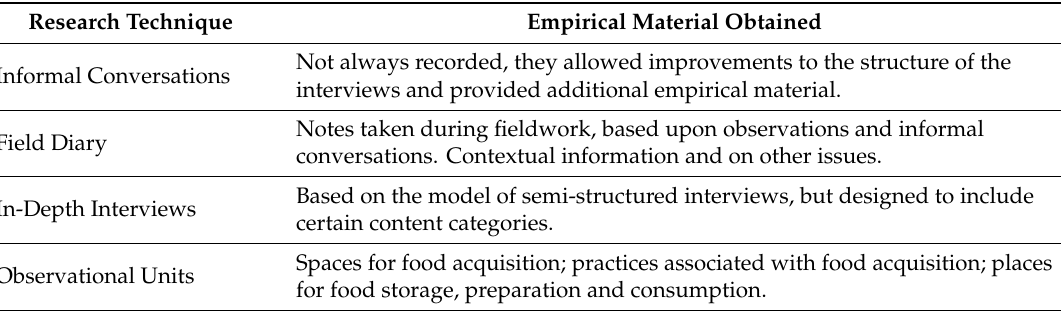
Table 2. Research techniques used in the